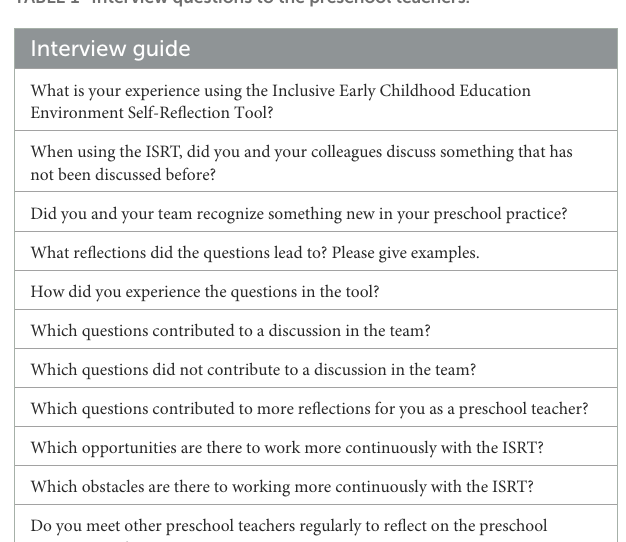
TABLE 1 Interview questions to the preschool